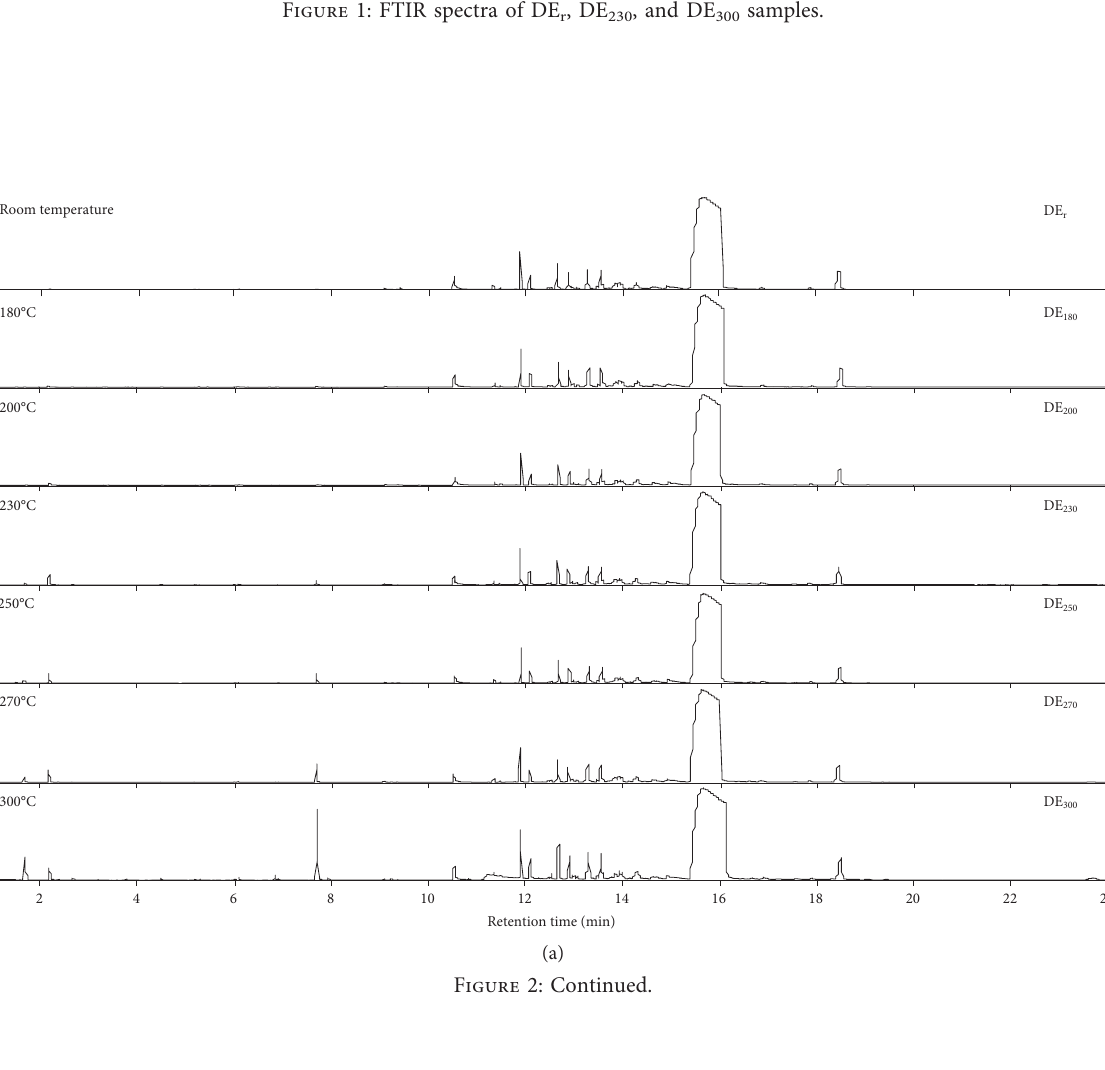
r , DE 230 , and DE 300 samples.